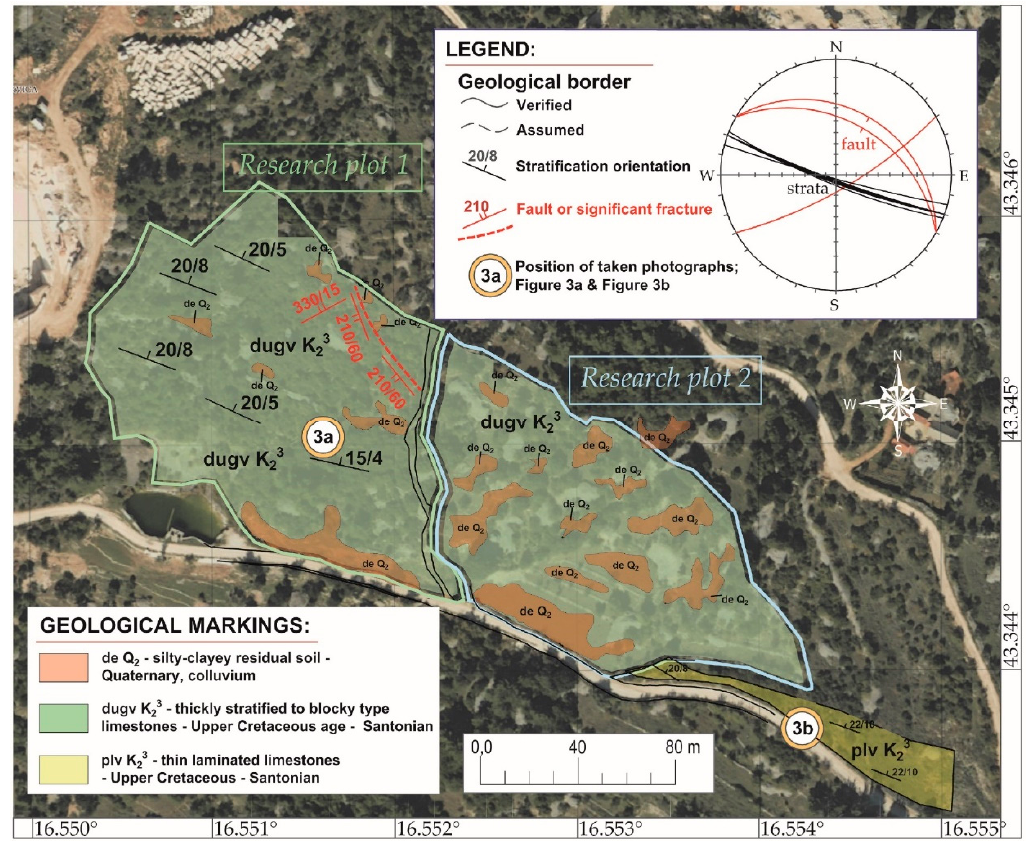
Figure 4. Engineering geological map of the investigated area. The majority of surface visible rock mass structural elements on rock outcrops were recorded on Research Plot 1. Observed fault position is also depicted on the map.